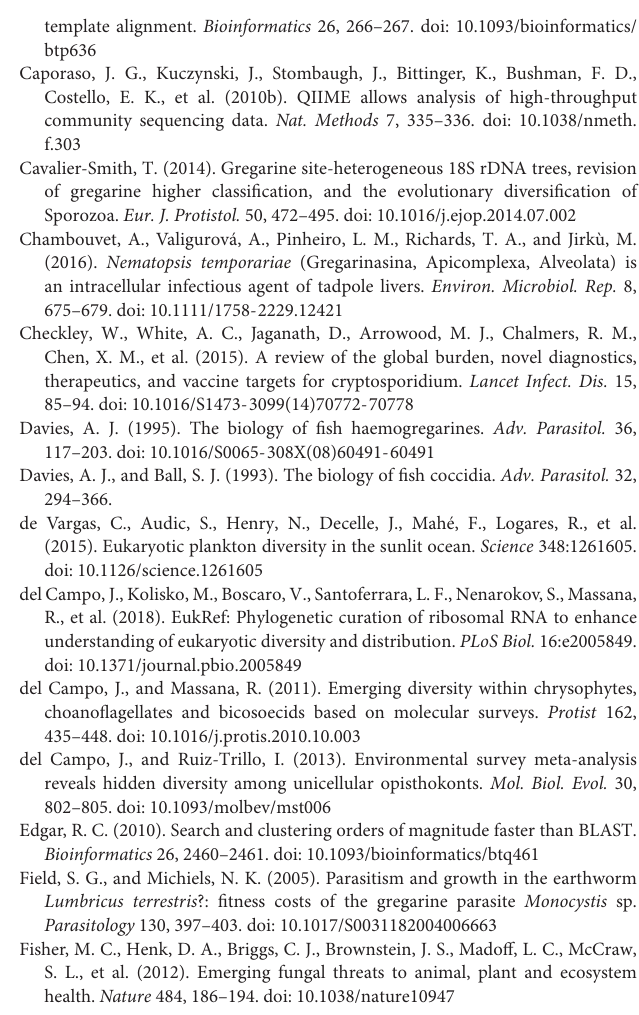
FIGURE S1 | Apicomplexan environment distribution heatmap based on the information associated to the sequences retrieved from HTES studies for different environmental features: redox state, open ocean vs. coastal, depth, size fraction, and temperature.